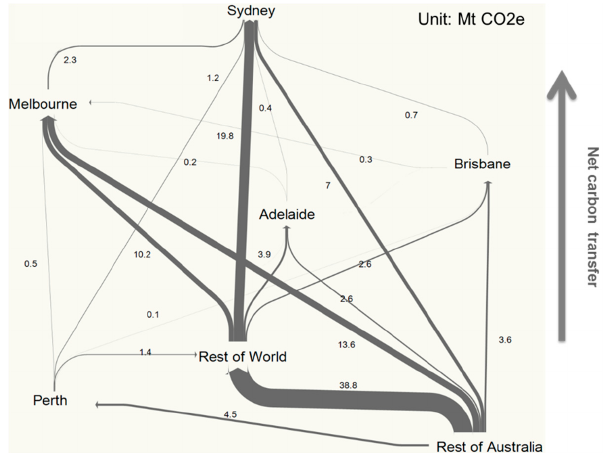
Figure 6. The hierarchy of net carbon transfer (net flow of embodied GHG emissions) among the seven regions.